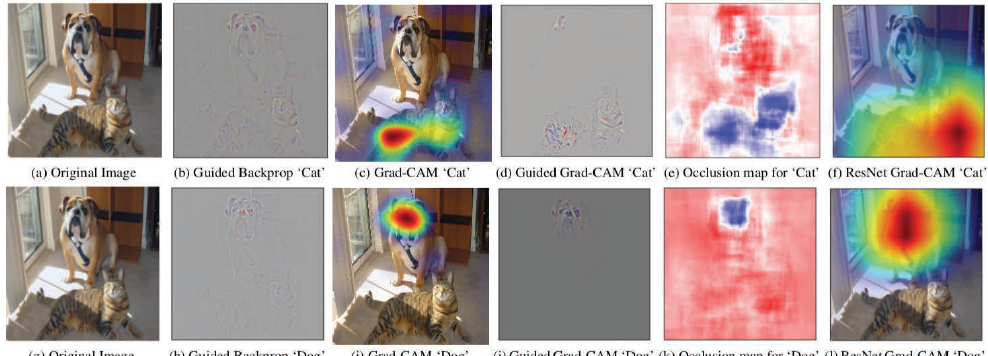
Figure 10. Gradient-weighted Class Activation Mapping (Grad-CAM) [86] explains the outcome decision of cat or dog, respectively, of an input image using the gradient information to understand the importance of each neuron in the last convolutional layer of the